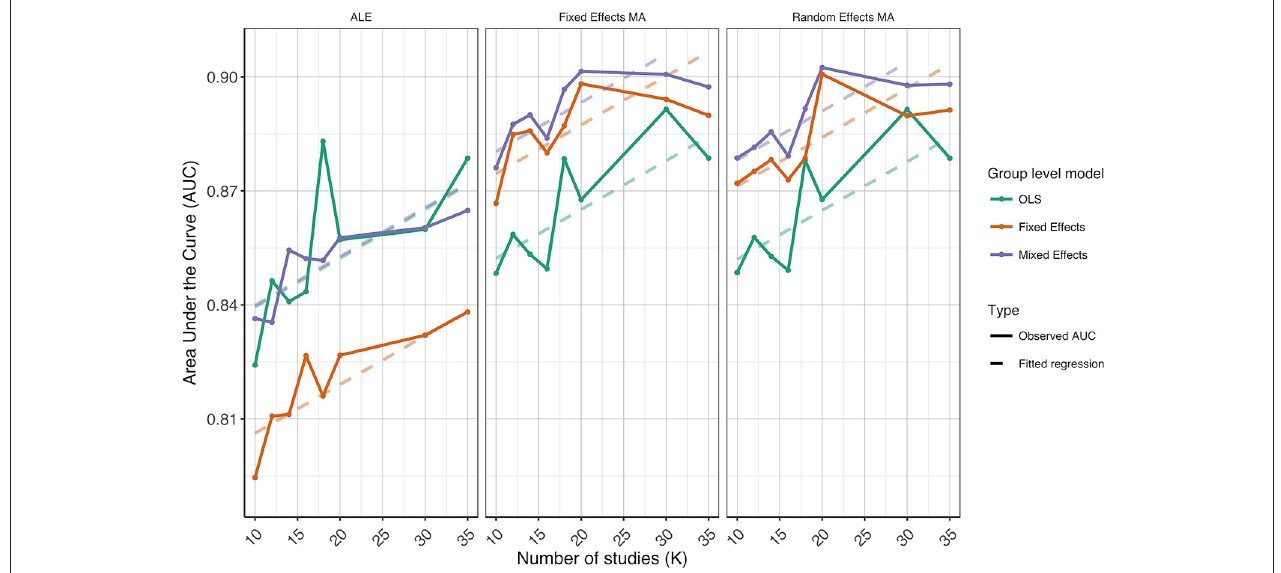
FIGURE 6 | Values of the area under the curve averaged over all folds for all K . The 3 panes correspond to the methods of CBMA while the 3 colors correspond to the group models. Solid lines are the observed values of the AUC. The dashed lines correspond to the fitted regression